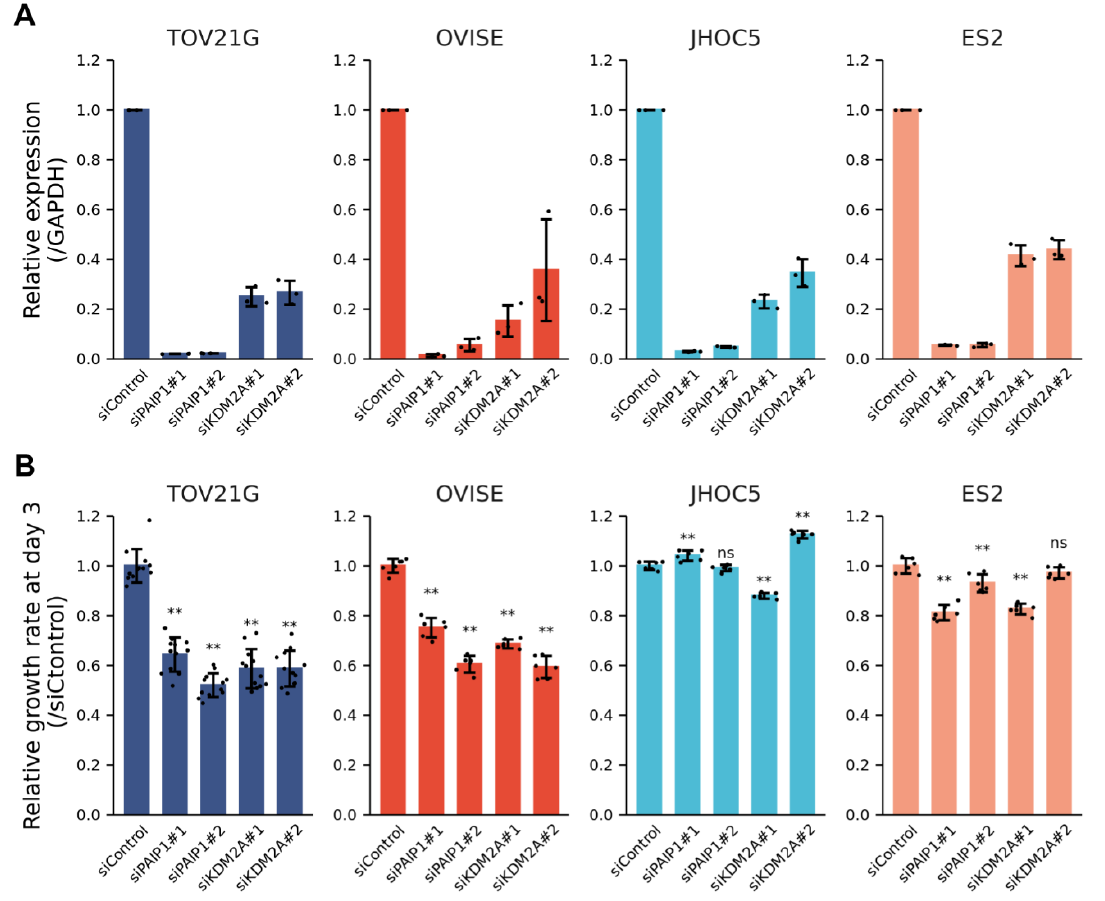
Figure 4. Effects of KDM2A or PAIP1 knockdown on OCCC cell proliferation. ( A ) Expression of KDM2A and PAIP1 in OCCC cell lines transfected with control siRNA or siRNA targeting KDM2A or PAIP1. Results are expressed as the mean ± s.d. ( n = 3). * p < 0.05, unpaired t -test. ( B ) Growth of OCCC cell lines transfected with control siRNA or siRNA targeting KDM2A or PAIP1. Results are expressed as the mean ± s.d. (TOV21G: n = 12, OVIISE, JHOC5 and ES2: n = 6). ** p < 0.01, ns: not significant, unpaired t -test.